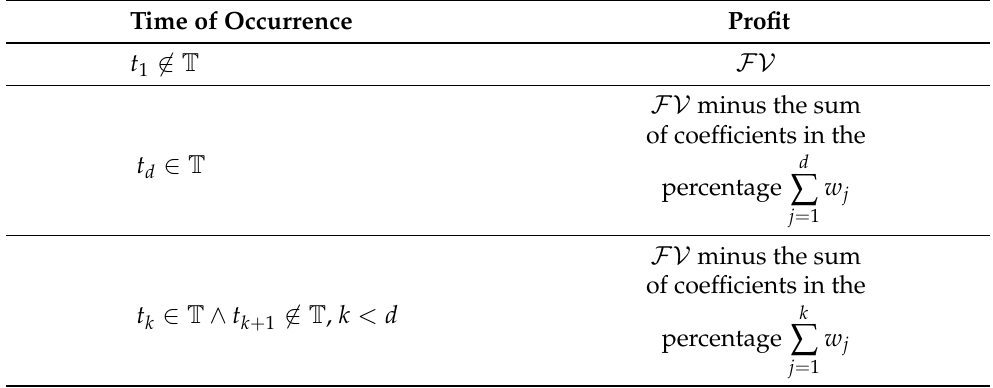
Table 4. Summary of the bondholder